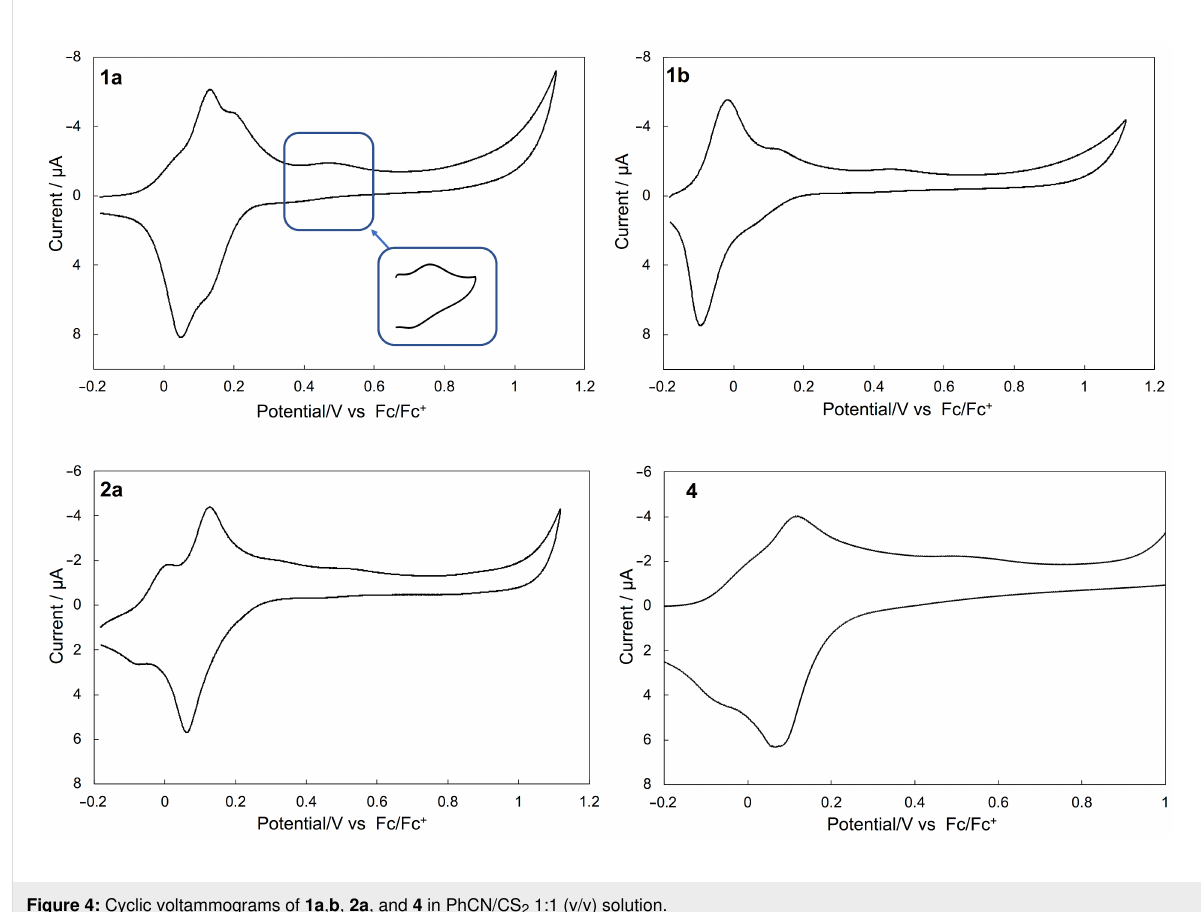
Figure 4: Cyclic voltammograms of 1a , b , 2a , and 4 in PhCN/CS 2 1:1 (v/v) solution.